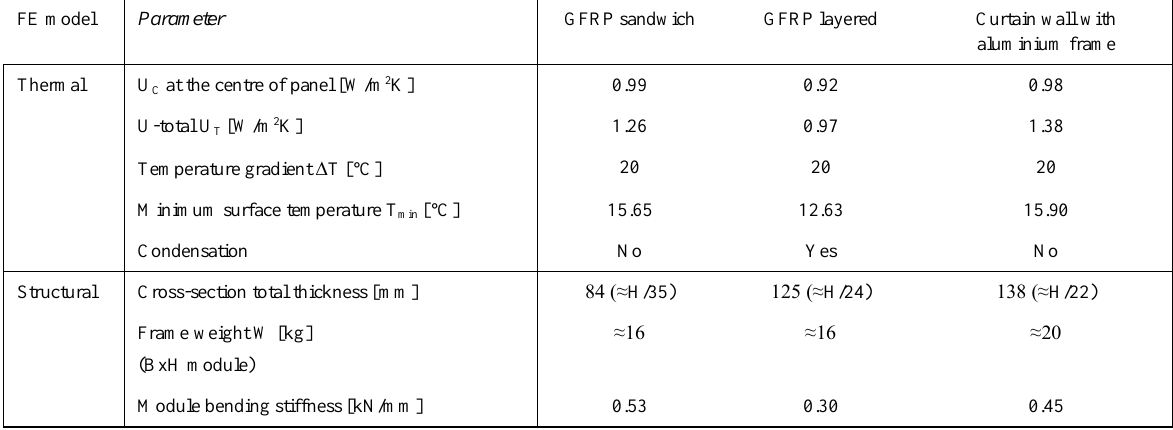
Table 3: Thermal and mechanical material performances of selected FE models